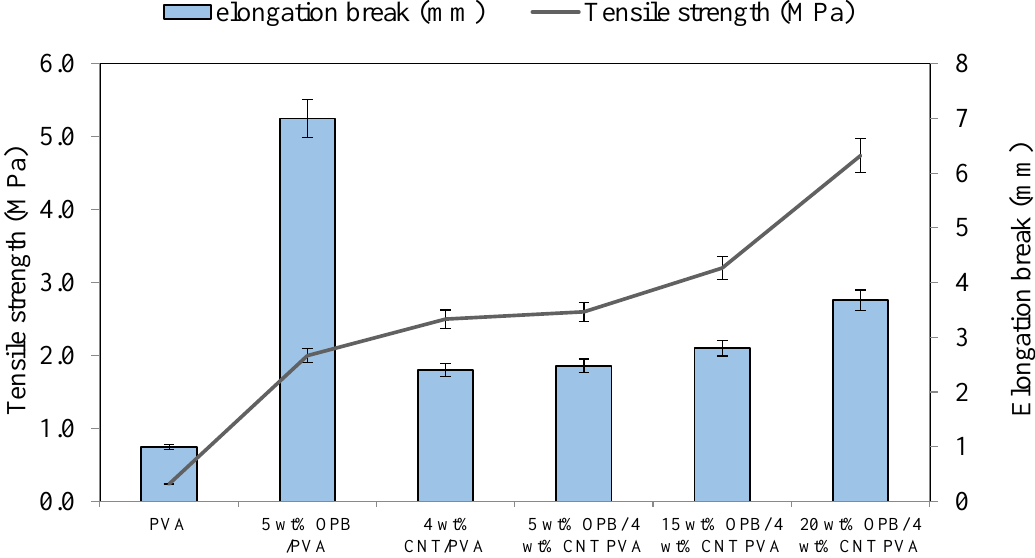
Figure 6. Elongation at break and tensile strength of non-reinforced and PVA hydrogels with 4 wt % MWCNTs at different amount of OPB. Experimental conditions: crosshead speed testing = 10 mm/min, ASTM D638 at room temperature.